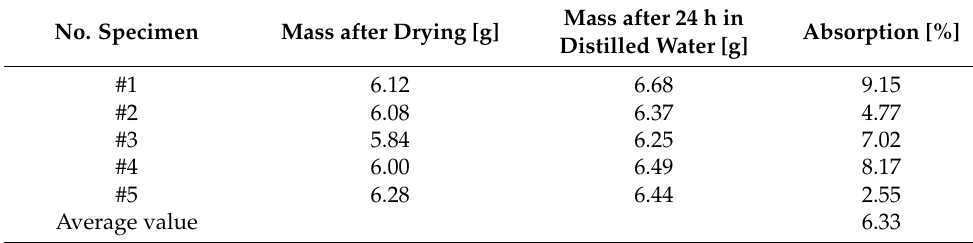
Table 7. Hydraulic oil absorption of Ecoflex 00-10 test specimens.